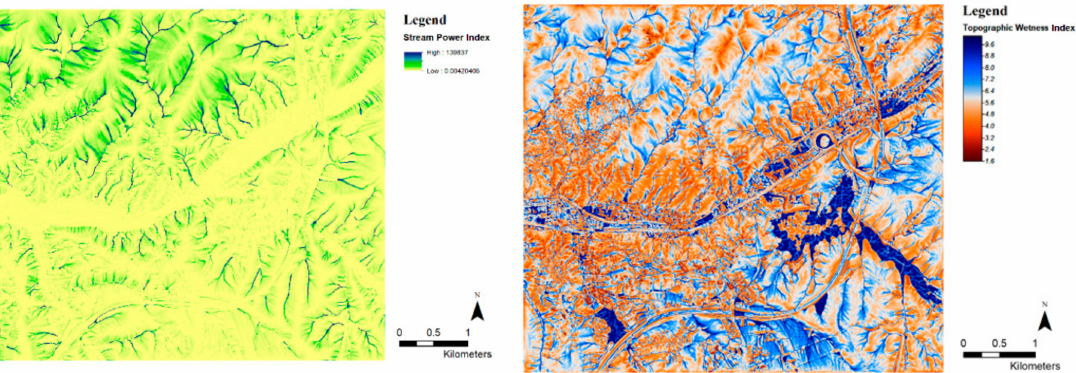
Figure 7. SPI (stream power index, on the left) and TWI (topographic wetness index, on the right) maps of the study